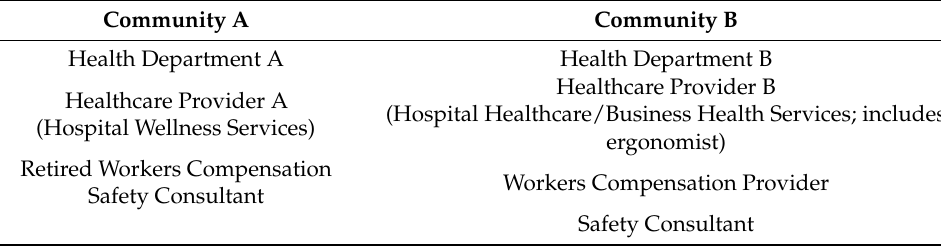
Table 1. Intermediaries for two communities.